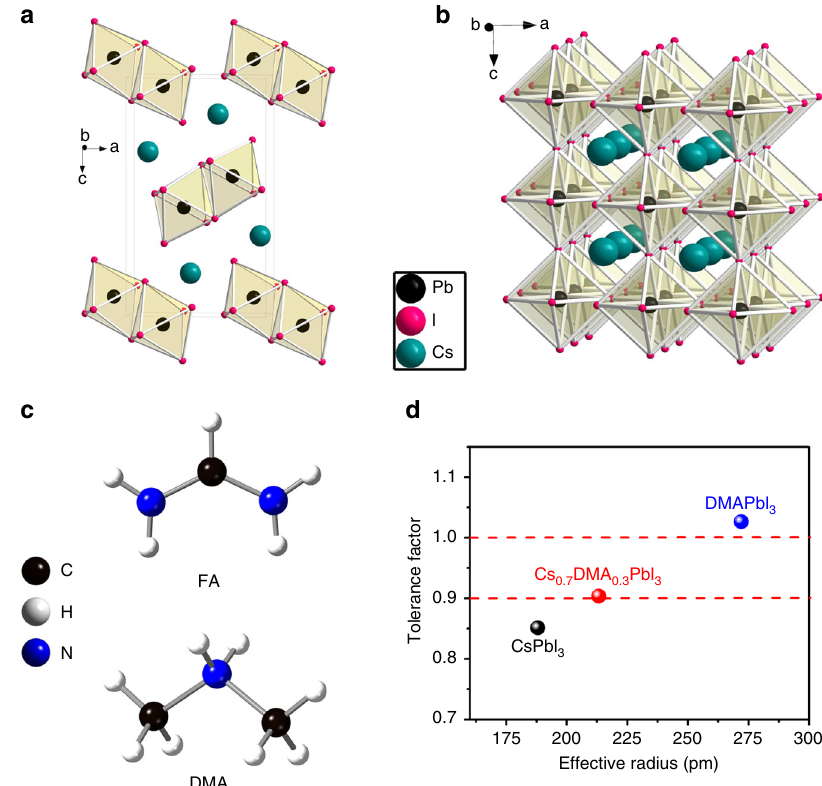
Fig. 1 Crystal and molecular structures. a Crystal structure of CsPbI 3 with non-perovskite yellow orthorhombic ( δ ) phase. b Crystal structure of CsPbI 3 with perovskite black cubic ( α ) phase. c Molecular structures of FA (top) and DMA (bottom) cations. d Tolerance factors of CsPbI 3 , DMAPbI 3 , and Cs 0.7 DMA 0.3 PbI